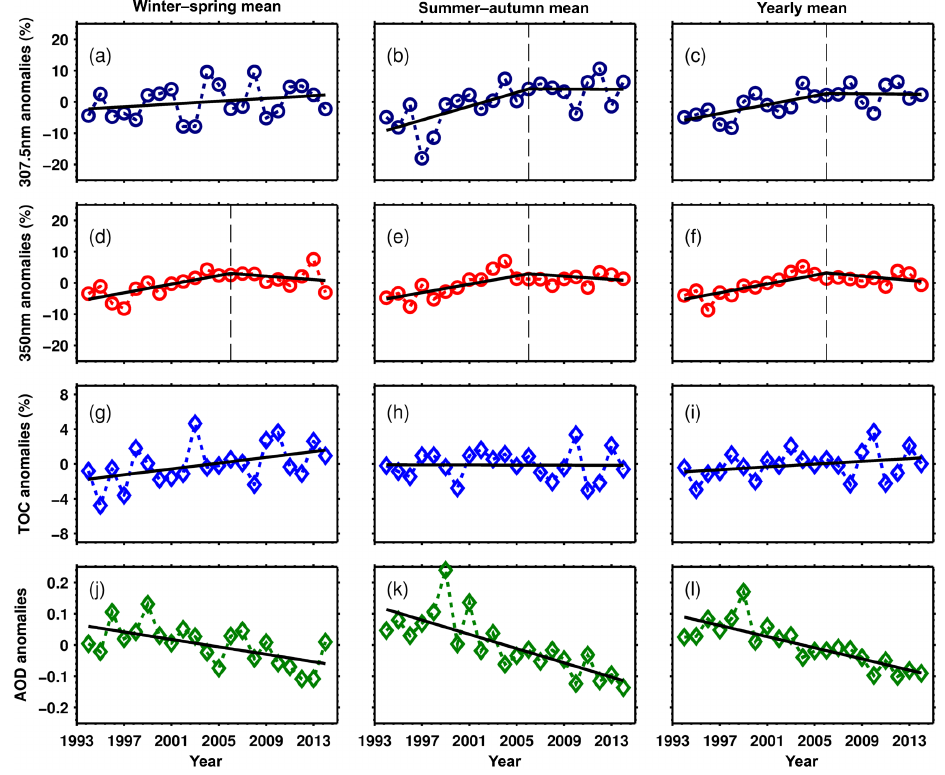
Figure 5. Yearly mean anomalies and corresponding trends for clear-sky irradiance at 307.5nm (a, b, c) and 350nm (d, e, f) , TOC (g, h, i) and AOD at 320nm (j, k, l) for December–May (left panels), June–November (middle panels) and for the entire year (right panels). A piece-wise trend consisting of two linear trends has been drawn when a statistically significant turning point has been detected; otherwise a linear trend for the entire period has been